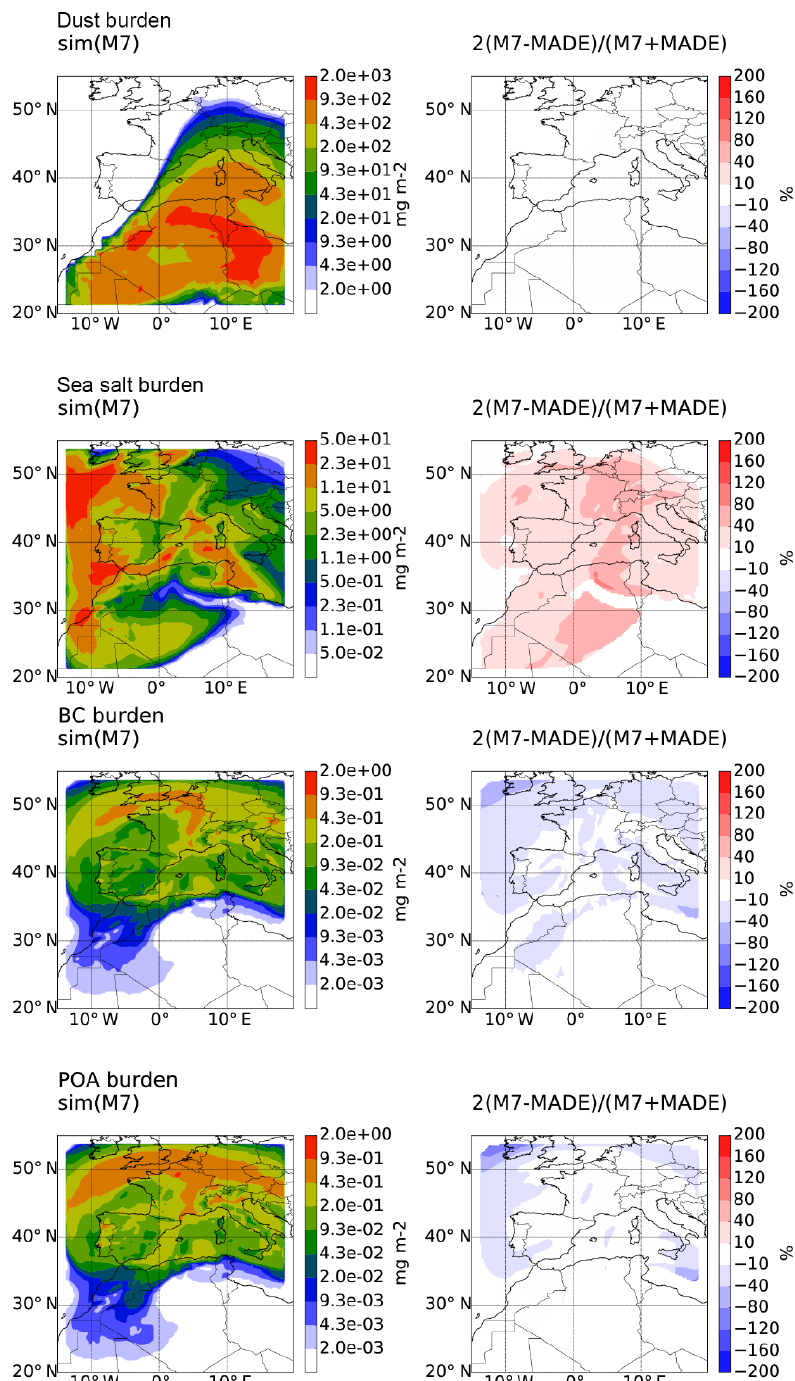
Figure 3. Aerosol burdens of dust (first row), sea salt (second row), BC (third row) and POA (last row) for M7 (left column; data points ex- ceeding the scale have been clipped to the maximum value) and differences to MADE (right column; to prevent diverging values, percentage differences (f 1 − f 2 )/ [ 0 . 5 (f 1 + f 2 ) ] , f 1 : M7, f 2 : MADE, are only determined for data points with f 1 / 2 ( lat , long ) > 0 . 01 · P 95 (f 1 ) , where lat and long denote latitude and longitude of the horizontal position and P 95 the 95th percentile of all data points in the domain) for sim simulations. Unless explicitly mentioned otherwise, aerosol burdens refer to dry aerosol